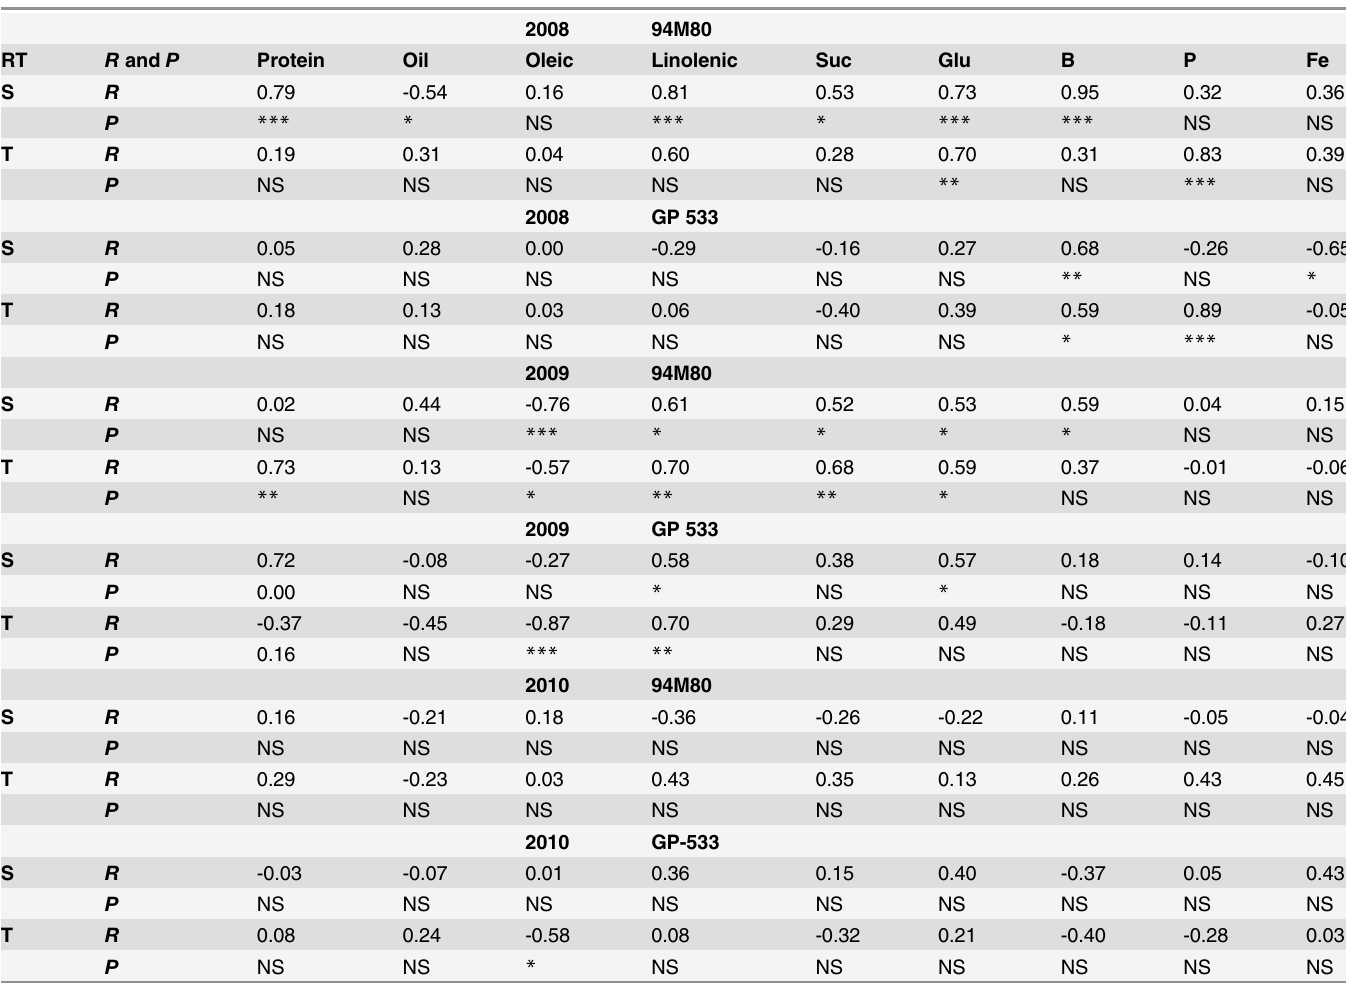
Table 8. Correlations ( R -values and P -values) between seeding rate (SR) and seed composition constituents (protein, oil, fatty acids, and sugars) and minerals (boron, B, phosphorus, P, and iron, Fe) in soybean cultivars grown on single- (S) and twin- (T) rows in Beulah fine sandy loam soil in soybean cultivars in 2008, 2009, and 2010 at Stoneville, MS, USA.